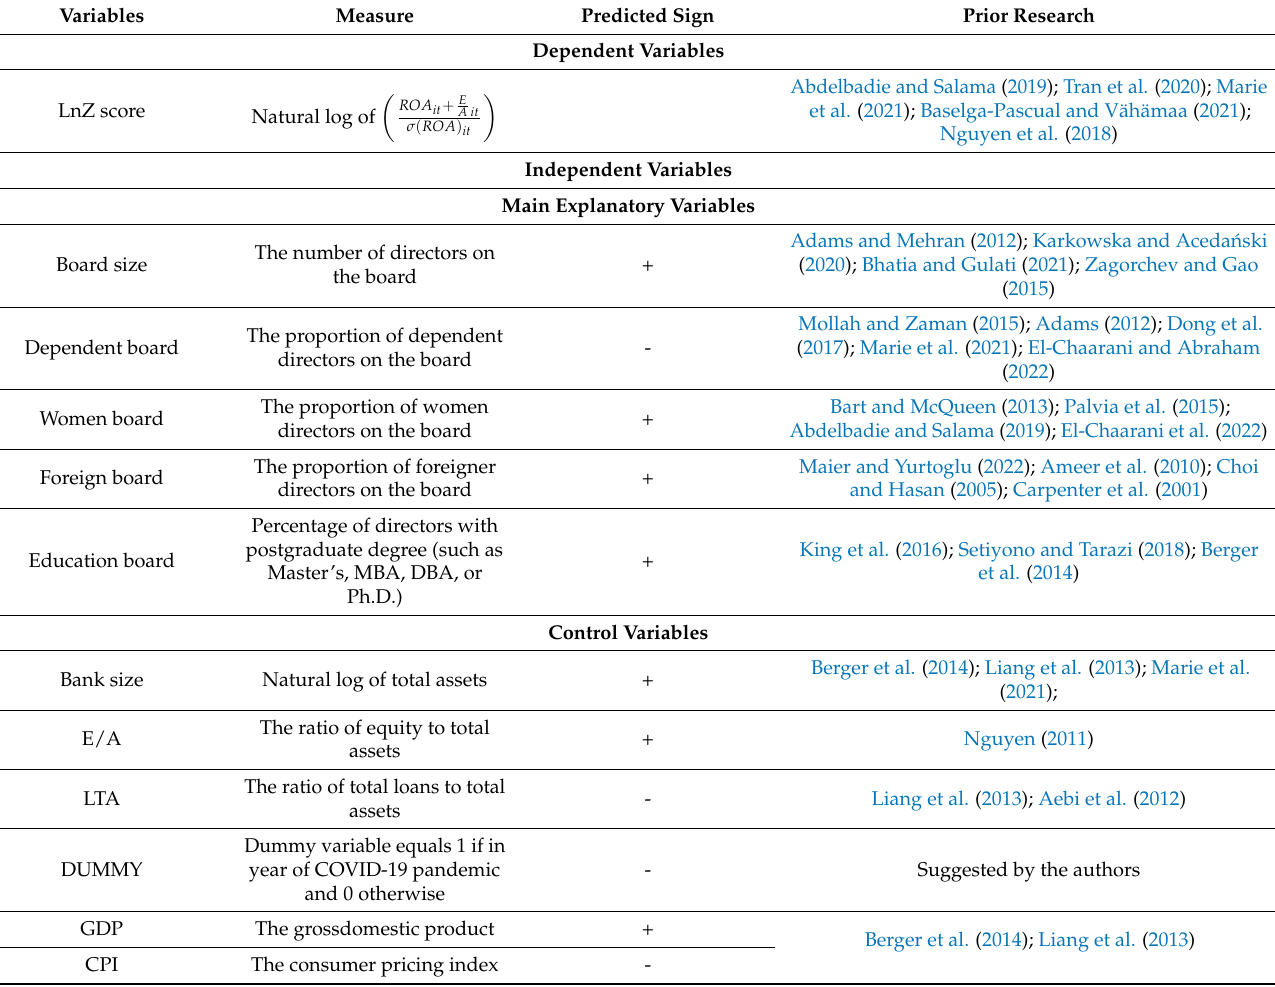
Table 1. Definition of